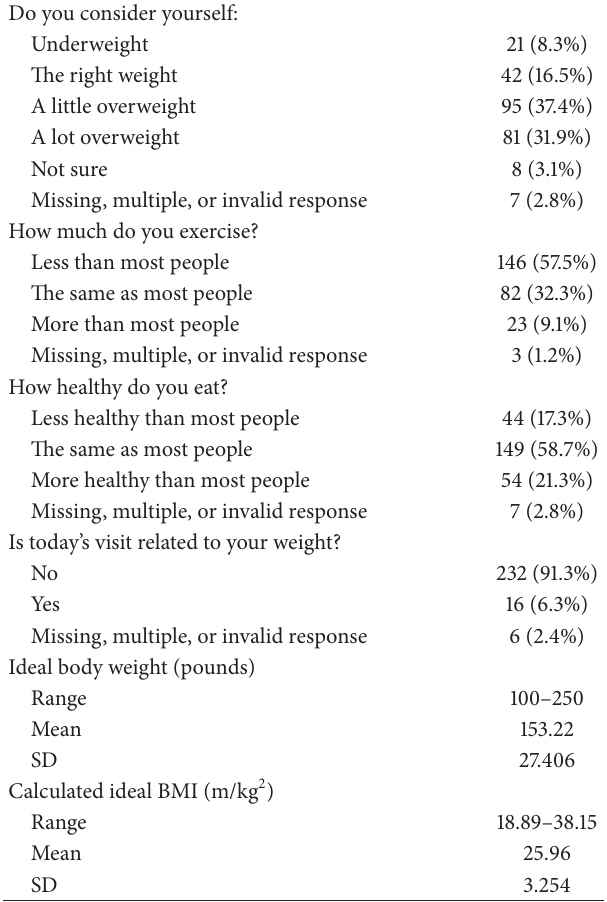
Table 2: Weight related perceptions of